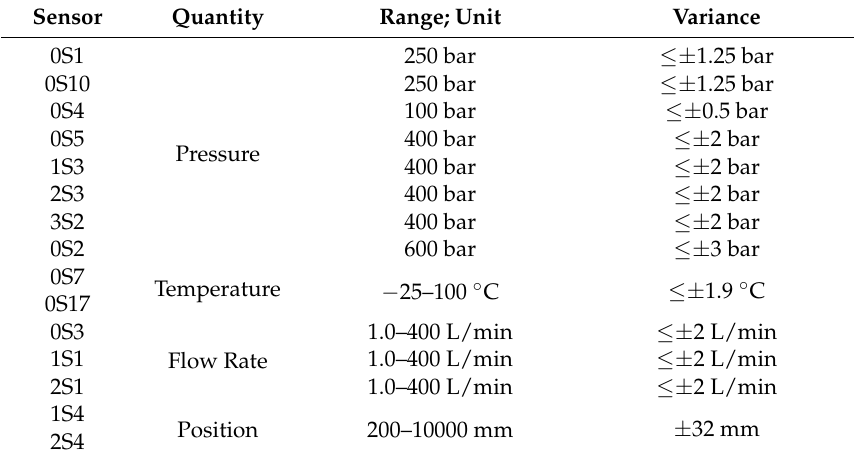
Table 4. Properties of the sensors used for the LS system test rig (see Figure 11).